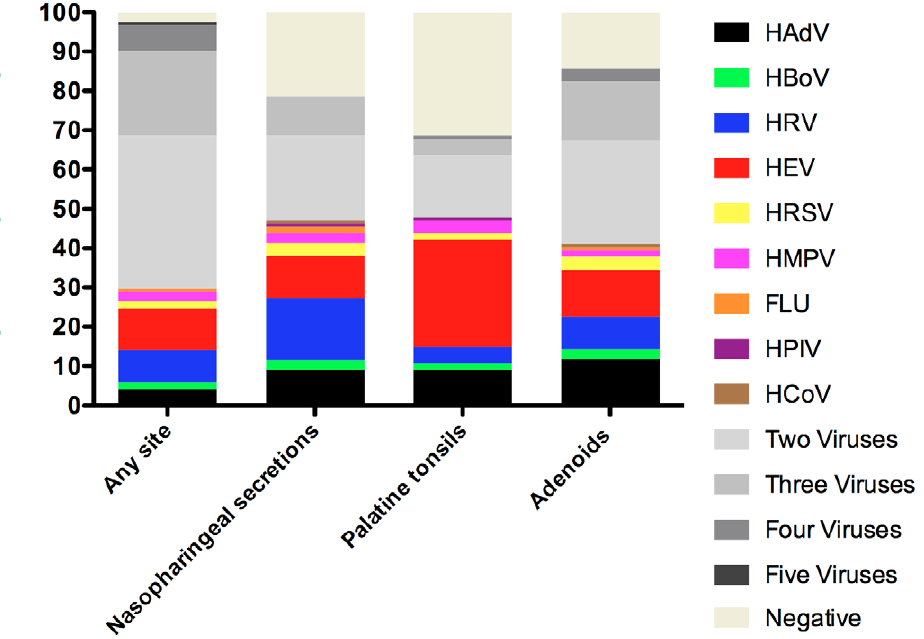
Figure 2. Frequencies of virus co-infections in different sample sites in 121 patients with chronic adenotonsillar diseases. doi:10.1371/journal.pone.0042136.g002 PLoS ONE |